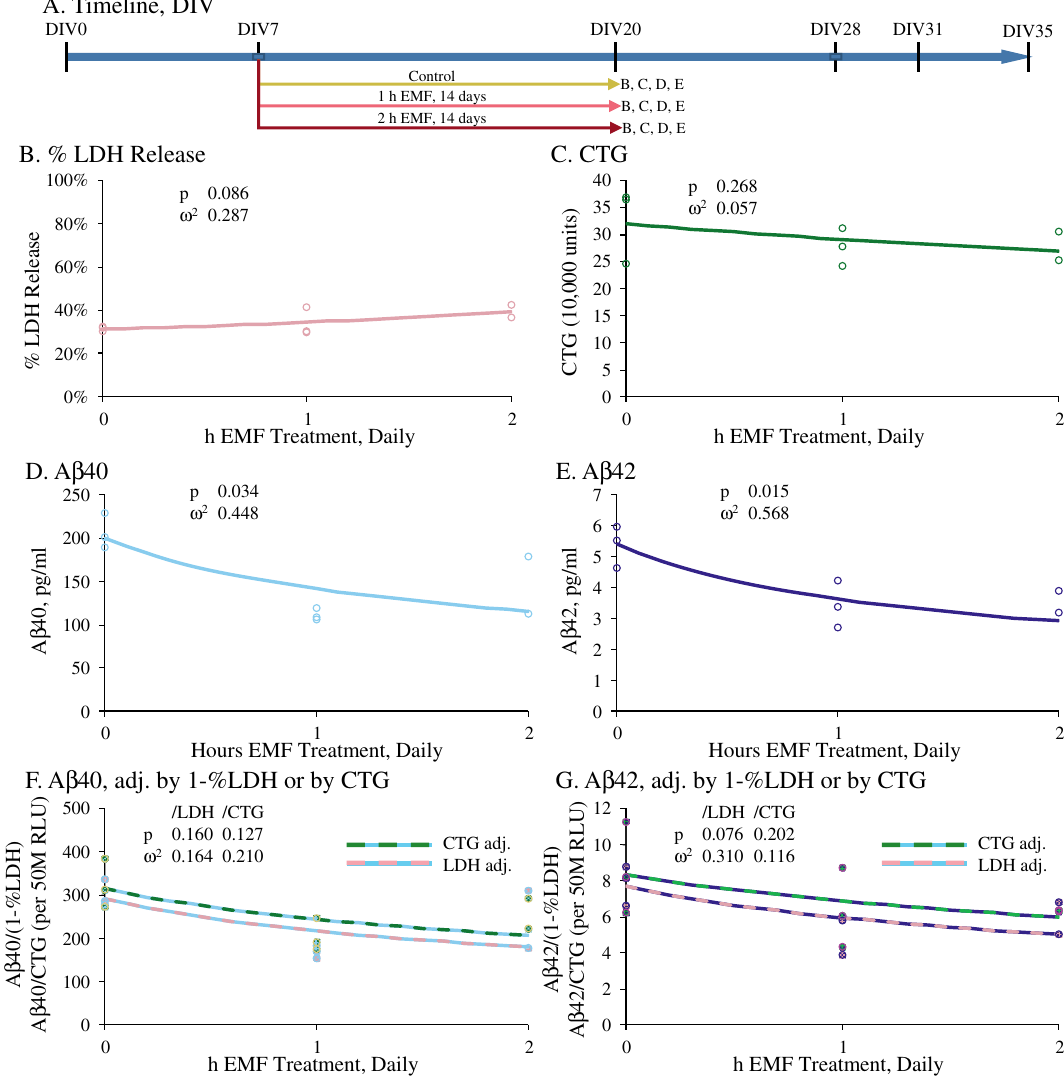
Figure 2. REMFS effects on Aβ40 and Aβ versus different exposure times in human brain cultures. PHB cultures were treated for 1 or 2 h at 64 MHz with a SAR of 0.4 W/kg and secreted Aβ40 and Aβ42 were measured in CM by ELISA as described in the text. Data is presented as individual measurements and corresponding regression lines. ( A ) Schedule of cell growth and treatments for data presented in figure. ( B ) LDH assay showed that REMFS treatment did not cause cell toxicity. ( C ) CTG data showed no significant change in cell viability dependent on exposure time. ( D ) Aβ40 versus daily exposure time. Aβ40 significantly ( p = 0.034) decreased as EMF exposure time increased. ( E ) Aβ42 versus daily exposure time. Aβ42 significantly ( p = 0.015) decreased as EMF exposure time increased. ( F ) Aβ40 adjusted by %LDH or CTG. When adjusted by 1-%LDH or CTG, reduction of Aβ40 was not significant ( p = 0.160 or 0.127, respectively) ( G ) Aβ42 adjusted by %LDH or CTG. When adjusted by 1-%LDH or CTG, reduction of Aβ42 was not significant ( p = 0.076 or 0.202,